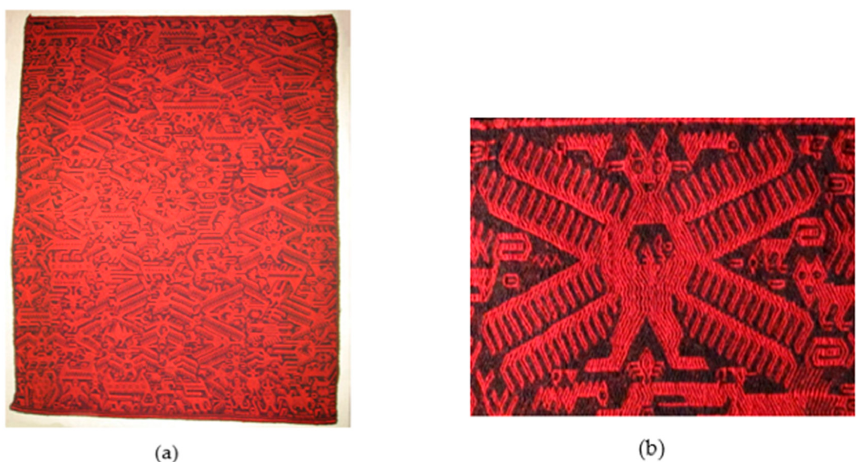
Figure 8. ( a ) Textile from Jalq’a, Bolivia (Fundaci ó n Antrop ó logos del Surandino, ASUR, Sucre, Bolivia, Figure 8 . ( a ) Textile from Jalq’a, Bolivia (Fundación Antropólogos del Surandino, ASUR, Sucre, Bolivia, photo: Andrea Nicklisch); ( b ) Representation of the supay (Fundación Antropólogos del photo: Andrea Nicklisch); ( b ) Representation of the supay (Fundaci ó n Antrop ó logos del Surandino, Surandino, ASUR, Sucre, Bolivia, photo: Andrea Nicklisch). ASUR, Sucre, Bolivia, photo: Andrea Nicklisch).